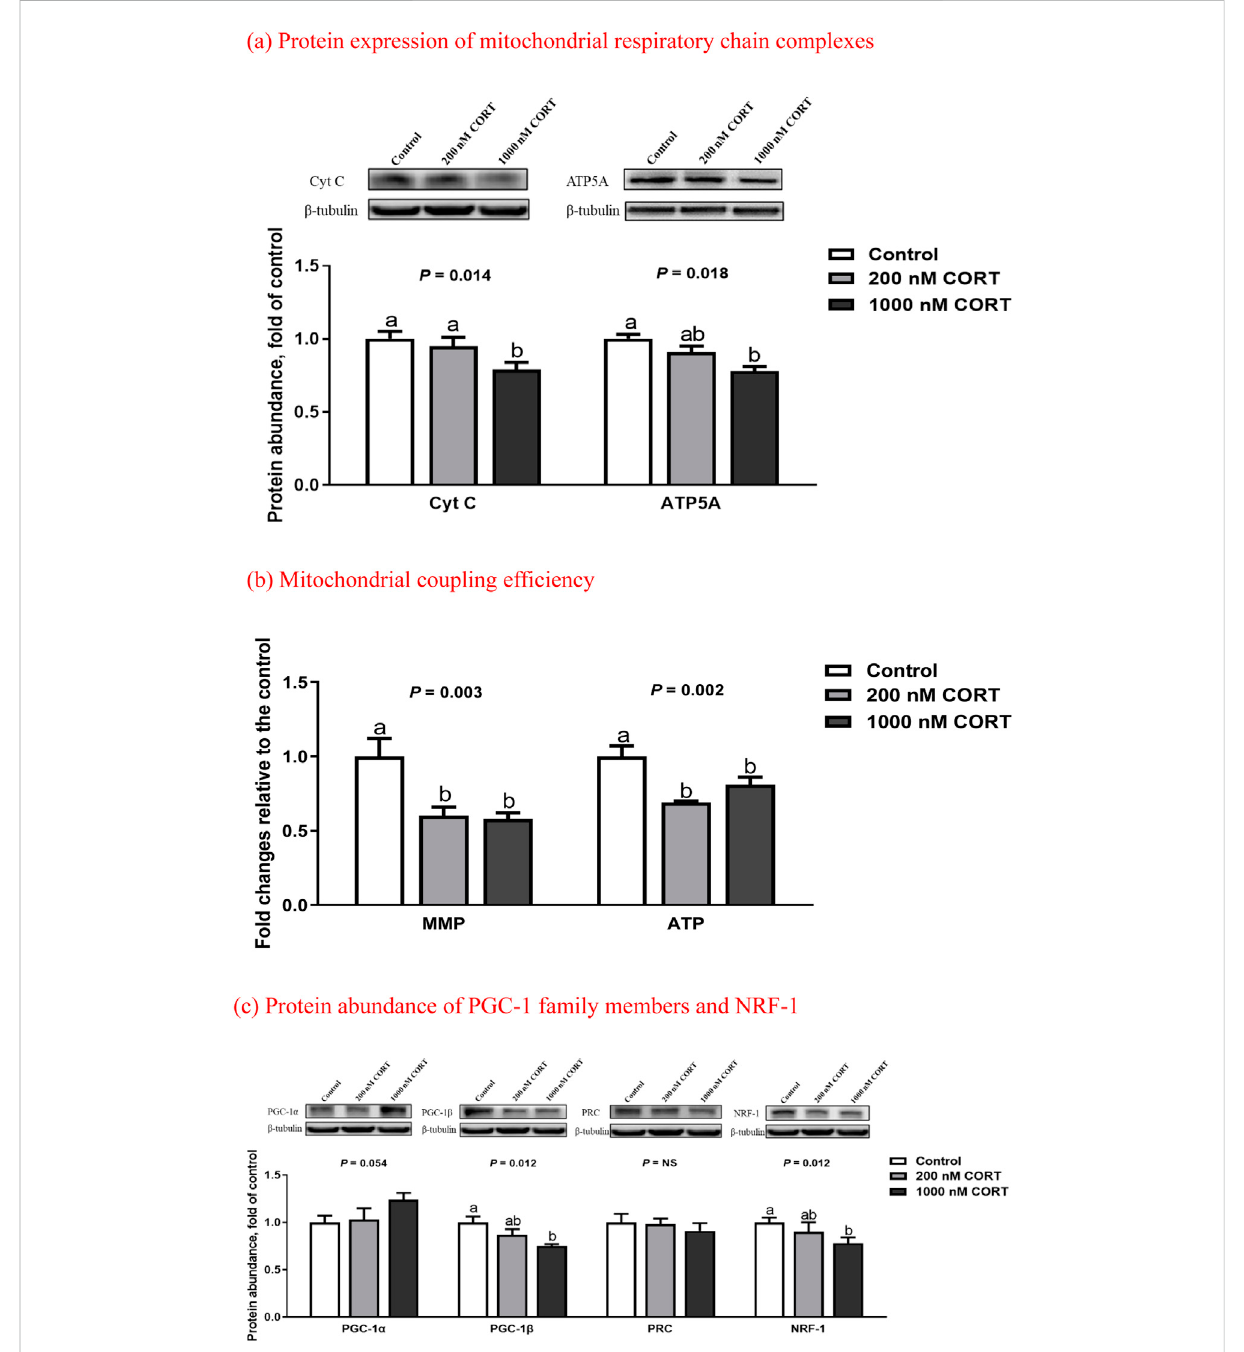
FIGURE 4 Protein expression of mitochondrial respiratory chain complexes (a) , mitochondrial coupling ef fi ciency (b) , and protein abundance of PGC-1 family members and NRF-1 (c) inembryonicchick myotubescultured with theindicated concentrations of corticosterone(CORT)for 24 h.Data are meansof6replicates. a,b Meanswithoutacommonsuperscriptdiffer( p < 0.05).CytC,cytochromeC;ATP5A,mitochondrialATPsynthase α -subunit; MMP, mitochondrial membrane potential; PGC-1, peroxisome proliferator-activated receptor γ coactivator 1; PRC, PGC-1 related coactivator; NRF-1, nuclear respiratory factor 1; NS, p >